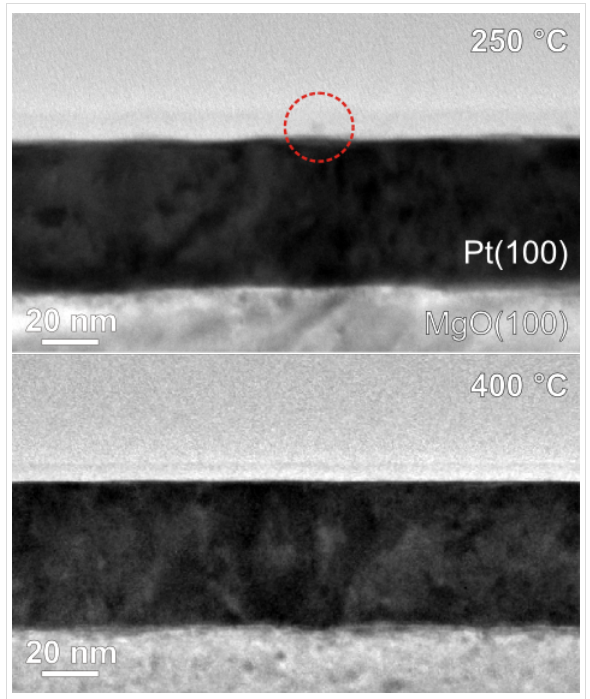
Figure 7: Bright field TEM images of Co NPs on Pt(100) films after annealing at T A = 250 °C (as-prepared state) and T A = 400 °C.